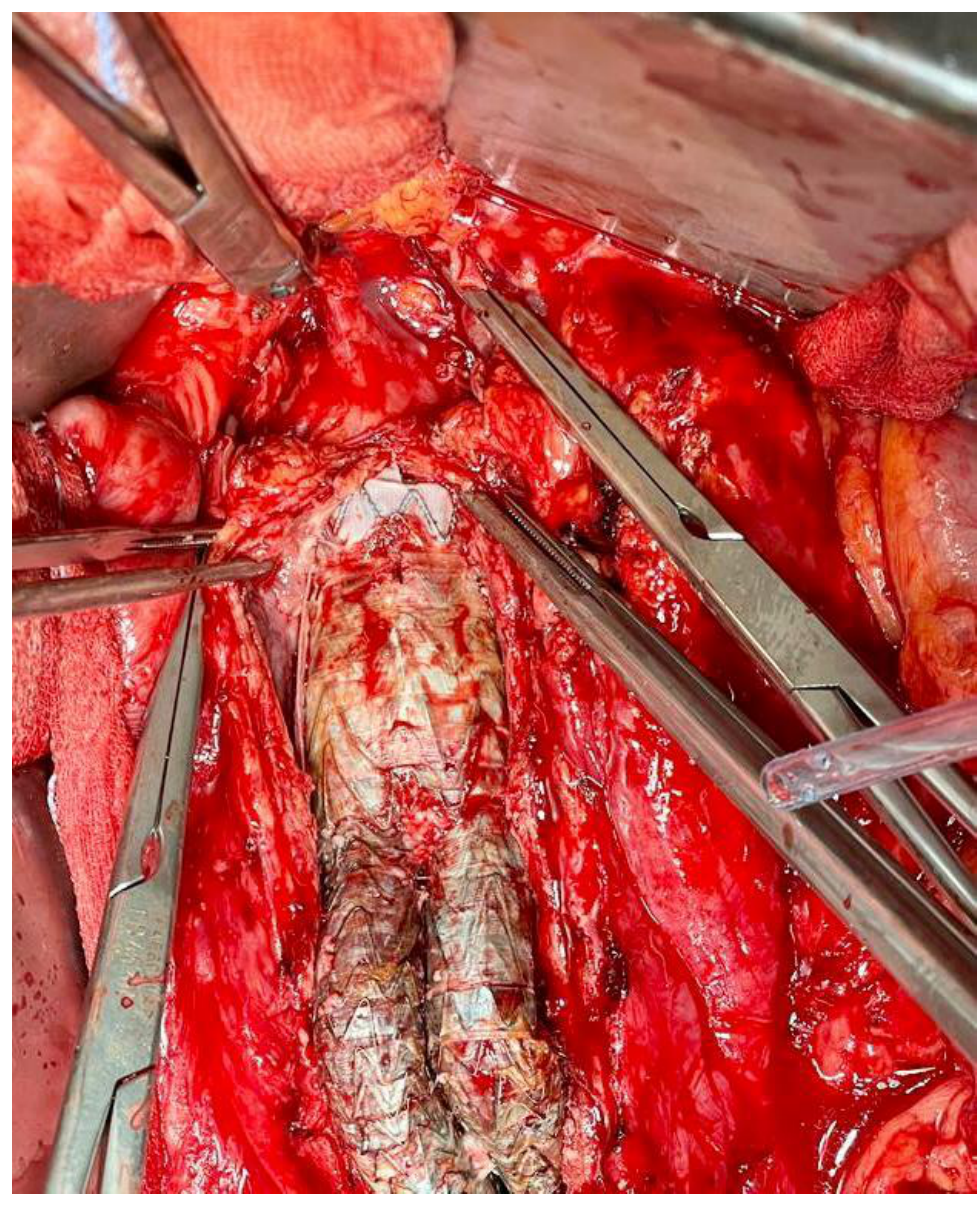
Figure 5. Explantation of an infected aortic and iliac endograft.